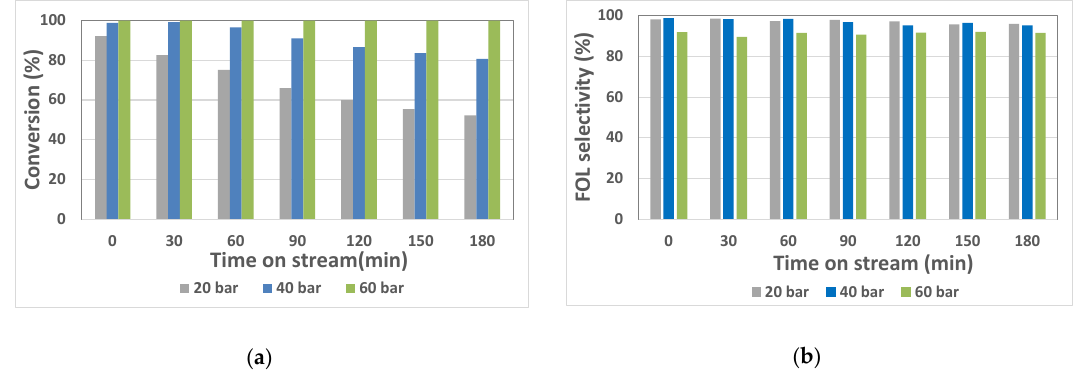
Figure 7. Effect of the hydrogen pressure. 5 g of furfural in 45 g of ethanol at 0.3 mL . min -1 flow rate. 150 °C in the presence of 260 mg of Co/SiO 2 . ( a ) conversion vs. TOS. ( b ) FOL selectivity vs. TOS.